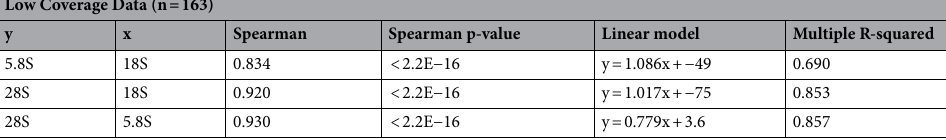
Table 7. Correlations between the three rRNA genes encoded in the 45S repeat unit in the low-coverage 1000 Genomes Project dataset. The Spearman correlation coefficient and linear models that describe the relationships between the 18S, 5.8S, and 28S copy numbers are shown.